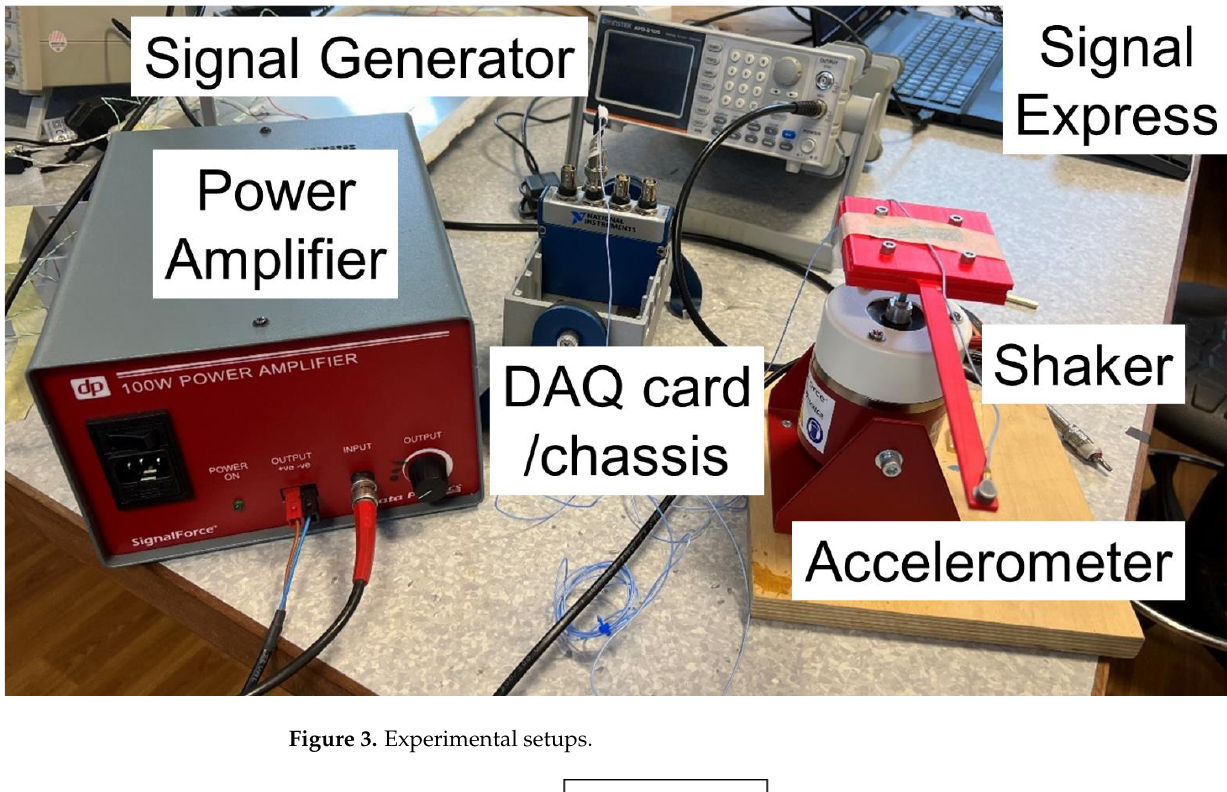
Figure 3. Experimental setups.